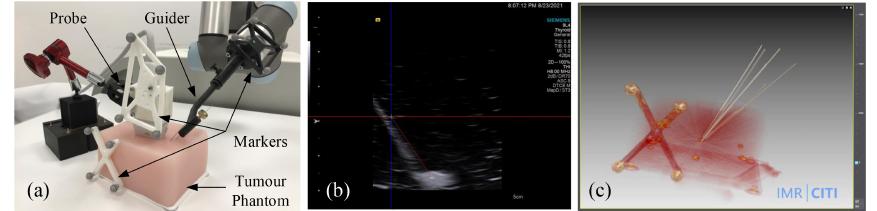
Figure 11. Soft tumor phantom biopsy experiments. ( a ) experimental setup including a robot arm with the guide, the soft tumor phantom with a reference frame atached, and the biopsy needle; ( b ) US image of a biopsy needle inserting into the tumor phantom; ( c ) CT image of the phantom after needle